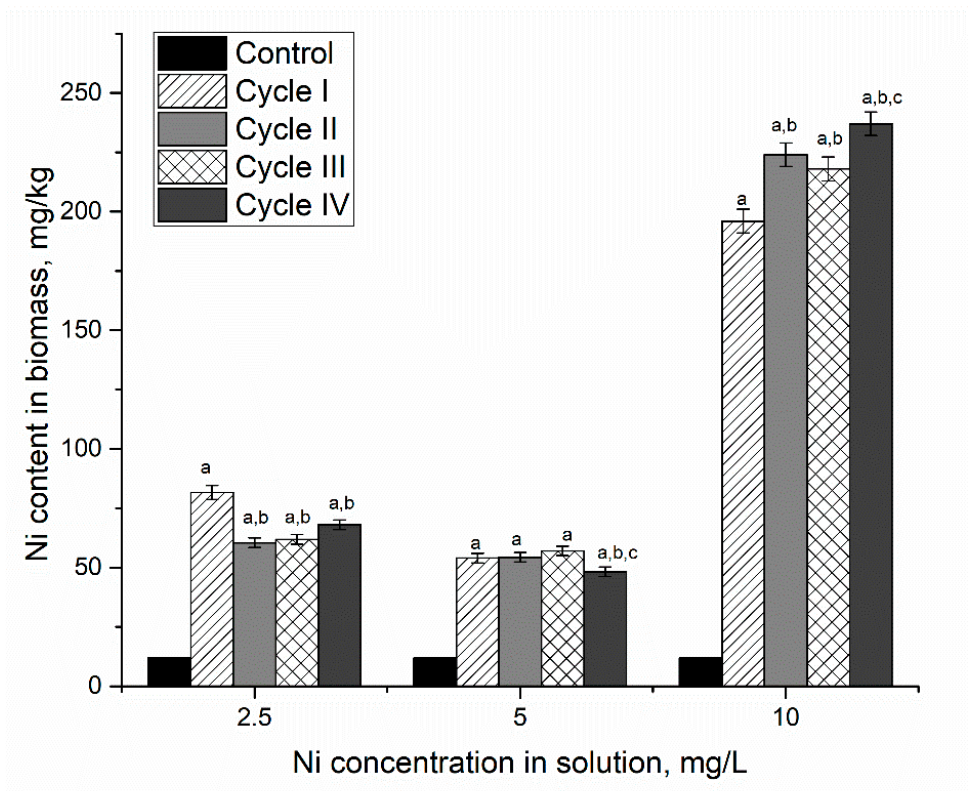
Figure 1. Accumulation of nickel ions in spirulina biomass during repeated cultivation in a medium containing nickel ions at concentrations of 2.5–10 mg/L. a: p < 0.001 for the difference between experimental and control samples; b: p < 0.001 for the difference with the first cycle; c: p < 0.001 for the difference with the second cycle.